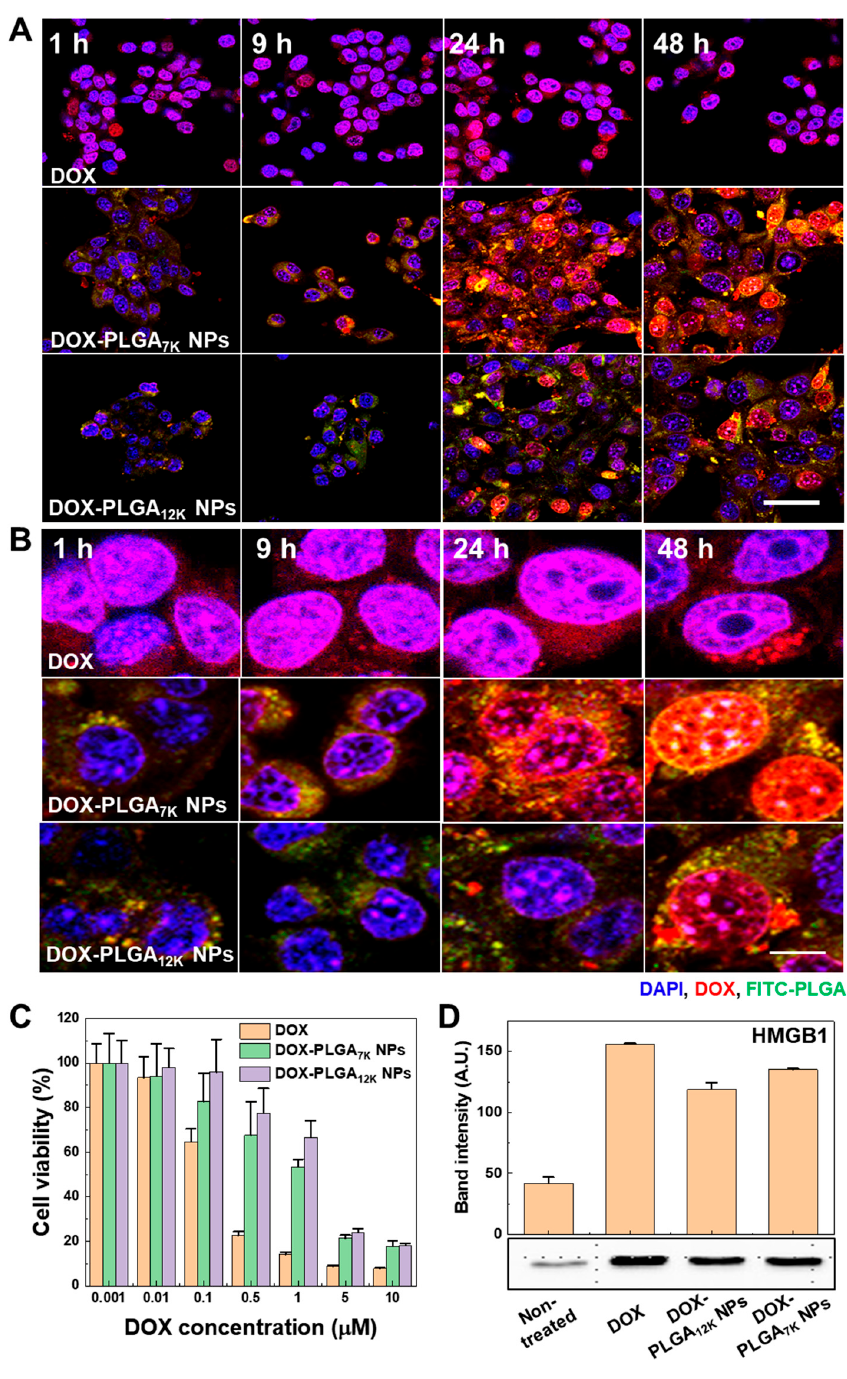
Figure 2. In vitro cellular uptake and immunogenic cell death on the CT-26 tumor cells. ( A ) Time- dependent cellular uptake of the DOX-HCl, FITC-labeled DOX-PLGA 7K NPs, and FITC-labeled DOX-PLGA 12K NPs. Blue channel: DAPI; Red channel: DOX; Green channel: FITC-labeled PLGA NPs. The scale bar indicates 20 µ m. ( B ) Magnified fluorescence images of the DOX-HCl-, FITC-labeled DOX-PLGA 7K NP-, and FITC-labeled DOX-PLGA 12K NP-treated CT-26 tumor cells. Blue channel: DAPI; Red channel: DOX; Green channel: FITC-labeled PLGA NPs. The scale bar indicates 5 µ m. ( C ) The cell viability of the CT-26 tumor cells treated with various concentrations (0.001 to 10 µ M of DOX) of DOX-HCl, DOX-PLGA 7K NPs, or DOX-PLGA 12K NPs for 48 h. ( D ) Western blot image and band intensity of HMGB1, which was released in the cell culture medium. CT-26 tumor cells were treated with DOX-HCl, DOX-PLGA 7K NPs, or DOX-PLGA 12K NPs (5 µ M of DOX) for 48 h.